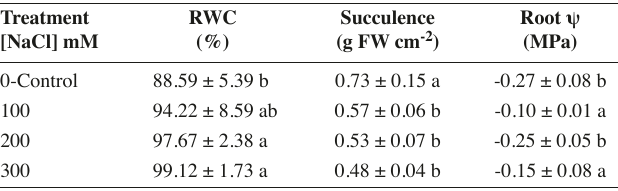
Tab. 2: Relative water content (RWC), succulence and root water potential (Ψ) in iceplant subjected to different salt conditions. Treatment